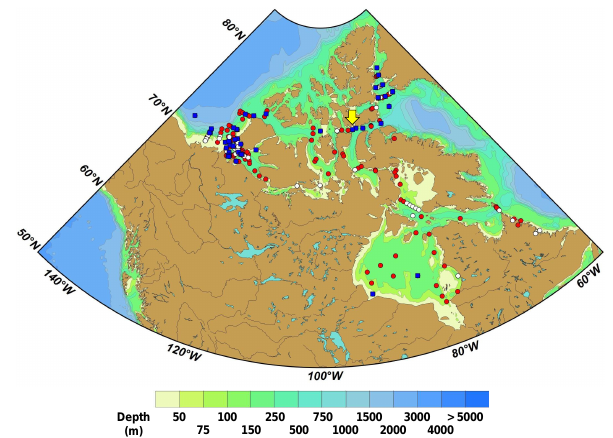
Fig. 1. Locations of all sampling stations (red circles) and those where incubations were performed (blue squares). Open symbols represent stations with no visible SCM, and the yellow arrow points to station 303, which is analyzed separately in the